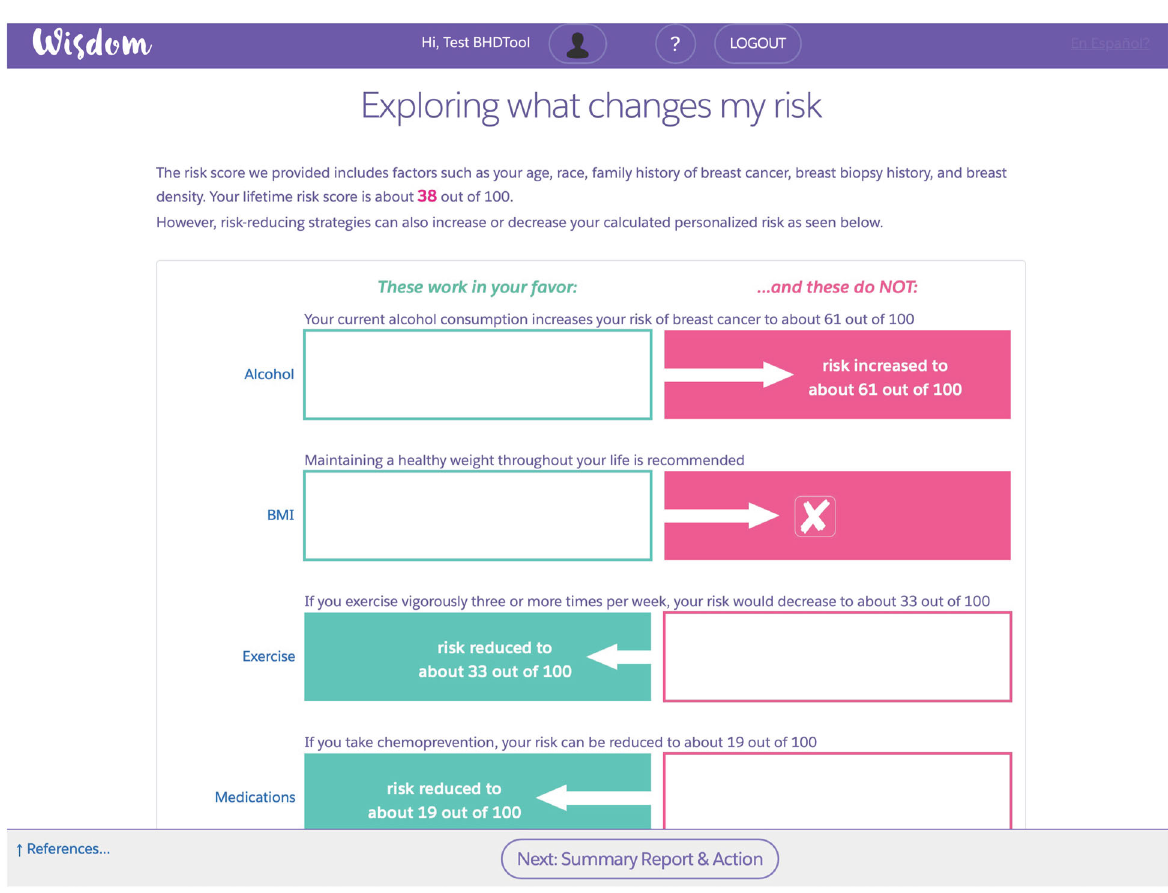
Fig. 3 Exploring what changes my risk. This is an example of a primary page summarizing how different risk-reducing strategies impact a participant ’ s absolute breast cancer